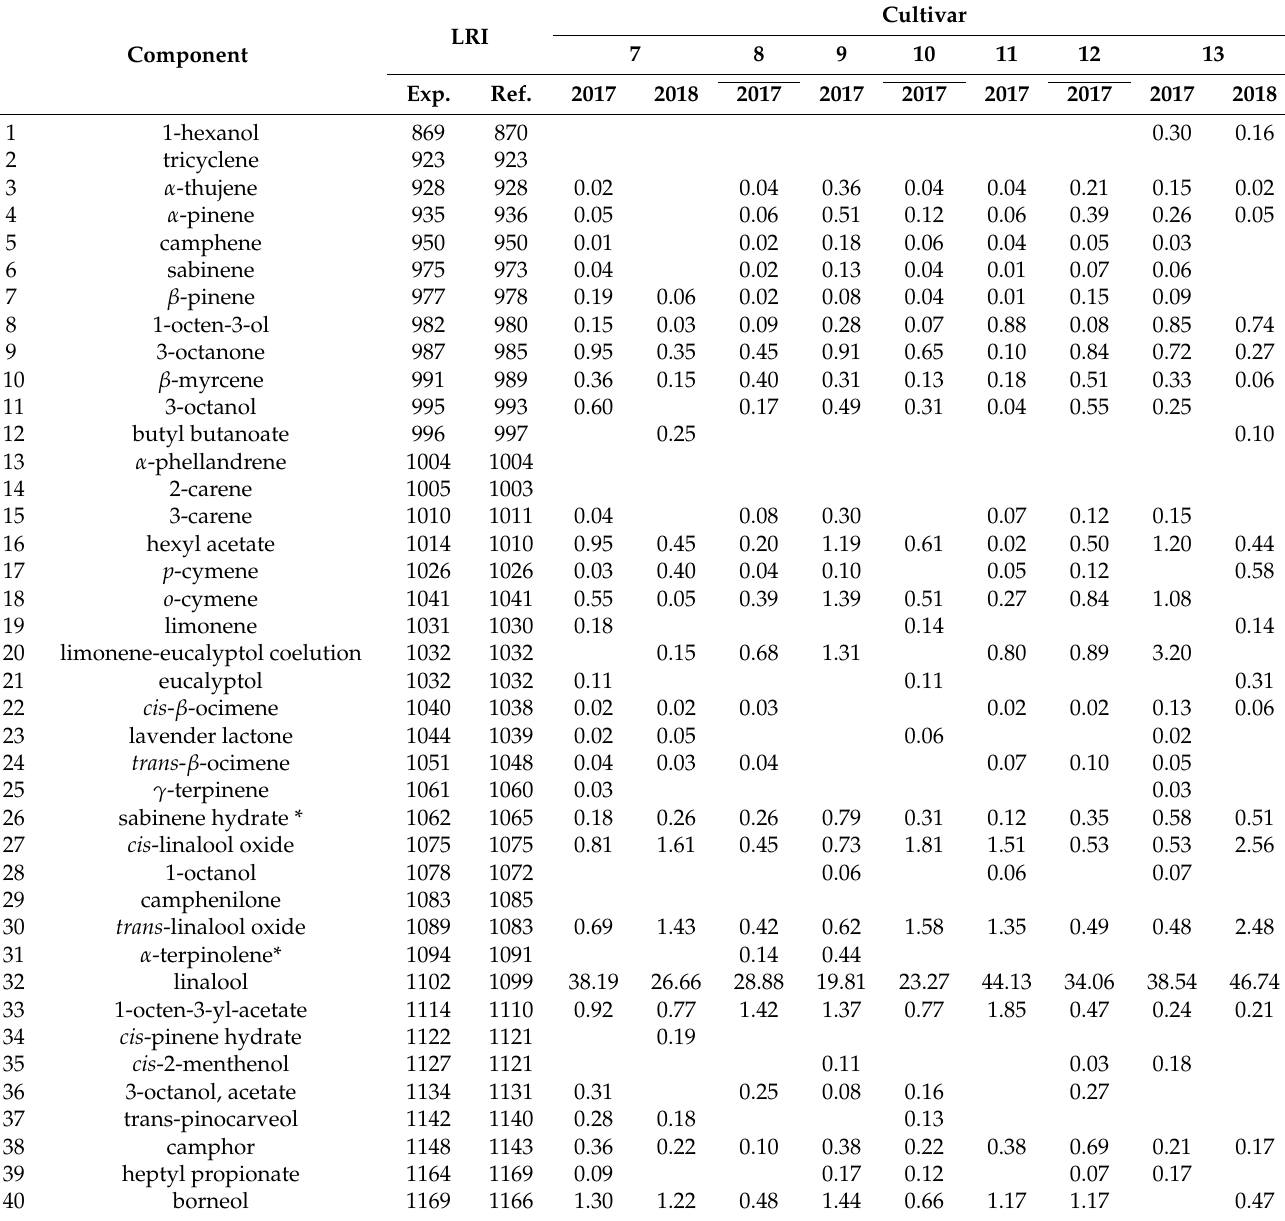
Table 2. GC data for the essential oil components identified in the samples from the different L. angustifolia cultivars (7–13). Apart from LRI (experimental and reference values), all the figures represent % abundance (area percent without solvent peak). * tentative